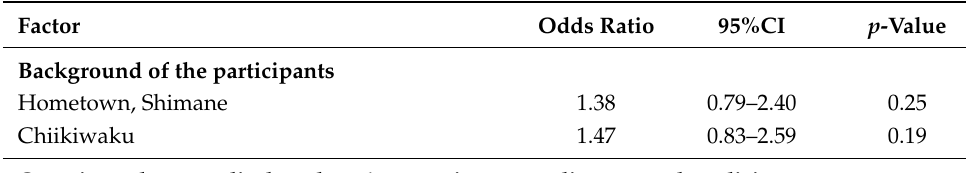
Table 4. Factors associated with the gap between medical students’ interest in and motivation for general